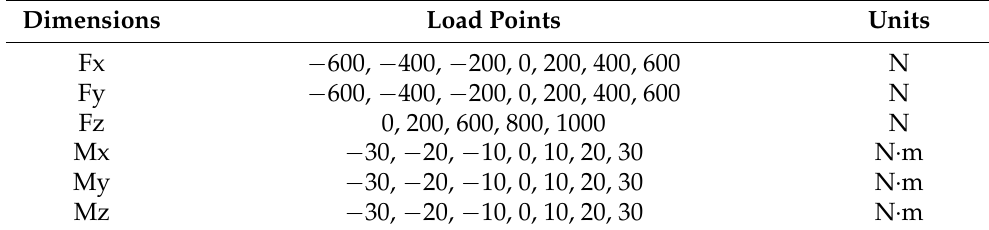
Table 1. Calibration experiment